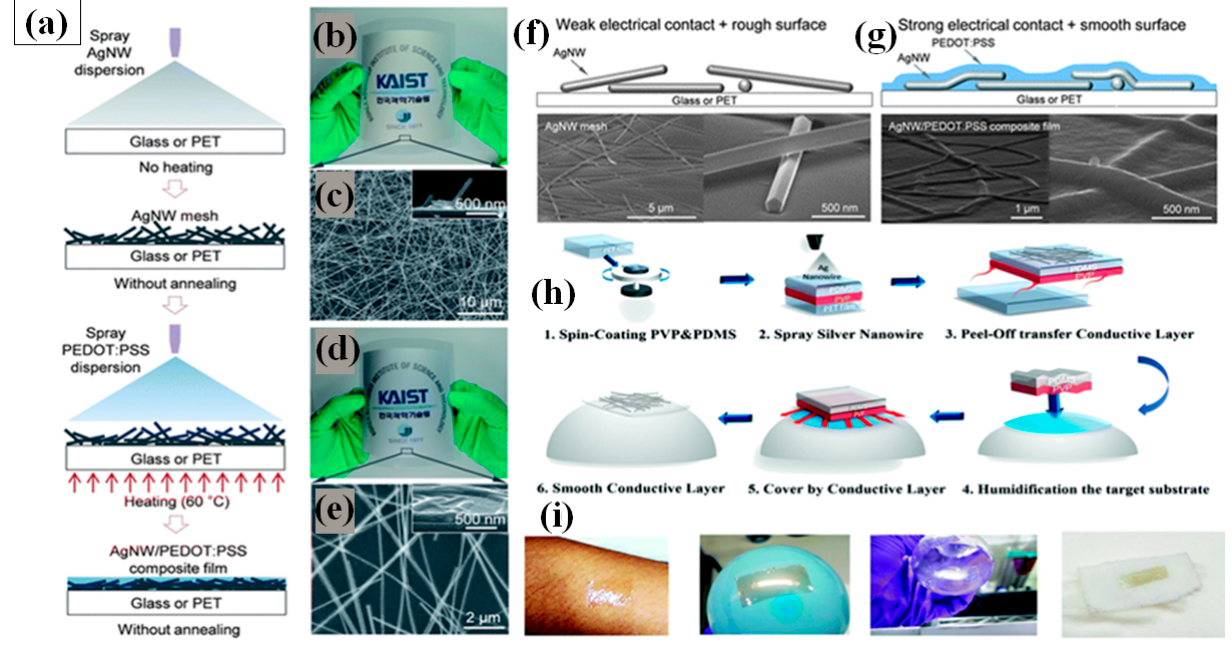
Figure 8. ( a ) Schematic diagram of the fabrication of AgNW–PEDOT:PSS composite electrodes through successive spray coatings. ( b ) AgNW mesh deposited on a flexible PET substrate by spray coating and its SEM image. ( c ) The inset image shows the cross-sectional view of the AgNW network. ( d ) AgNW–PEDOT:PSS composite film on a PET substrate with 81.7% (at 550 nm) of transmittance and 11.3 Ω /sq of sheet resistance. ( e ) SEM image of the AgNW–PEDOT:PSS composite film and a cross-sectional inset image. SEM image of AgNW film before ( f ) and after ( g ) PEDOT:PSS spray coating. (adapted from [144] with permission from Royal Society of Chemistry, 2013)Schematic of the Water Transfer technique process for AgNW TCEs. ( h ) (1) A prefabricated sacrificial layer (PVP) and a flexible framework (PDMS); (2) spraying of AgNWs on the top of PDMS after plasma treatment; (3) peel off the fabricated PVP-PDMS and AgNW film (4–5) transferred nanowire devices on a prehumidification target substrate with a sacrificial layer in between. (6) final film on random substrate ( i ) The corresponding photographs of various nonconventional substrates, including skin, a balloon, a round-bottomed flask, and an elastomeric textile (adapted from [149] with permission from Royal Society of Chemistry,